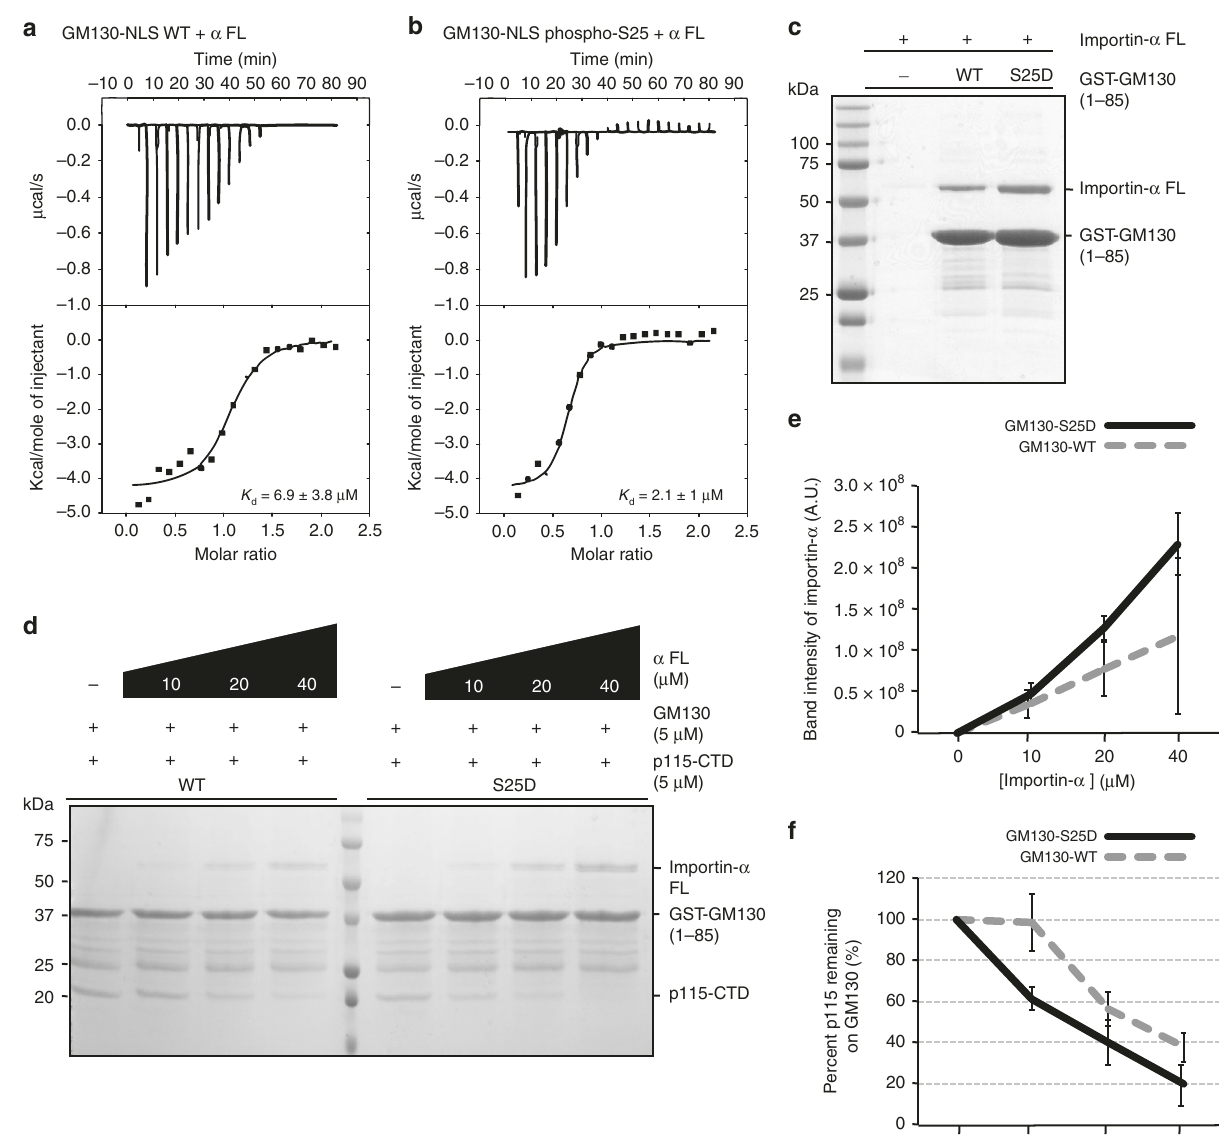
Fig. 3 GM130 interacts with full-length Importin- α . a , b ITC titration curves (upper) and binding isotherms (lower) of Importin- α FL with GM130-NLS WT ( a ) and GM130-NLS phospho-S25 ( b ). K d values are indicated. c Pulldown assays of Importin- α FL with GM130-WT or GM130-S25D. GST-tagged GM- 130-WT or GM130-S25D was incubated with Importin- α FL. GST-bound samples were analyzed by SDS – PAGE and stained with Coomassie blue. d Competition binding assay. p115-CTD was incubated with either GST-GM130-WT or GST-GM130-S25D in the presence of indicated concentrations of Importin- α FL. Samples pulled down by GST beads were analyzed by SDS – PAGE and stained with Coomassie blue. e , f Band intensities of Importin- α FL and p115-CTD from the SDS – PAGE gels in d were quanti fi ed and normalized by GST-GM130 intensity. Quantitative plots show normalized Importin- α FL intensities ( e ) and percent p115-CTD remaining on GM130 ( f ). Data represent mean ± standard deviation from three independent